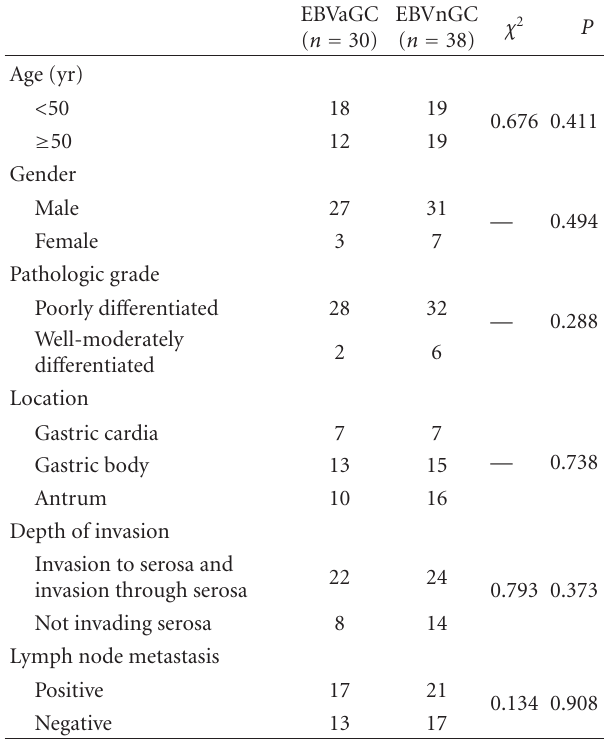
Table 2: Comparison of clinicopathological data between EBVaGC and EBVnGC